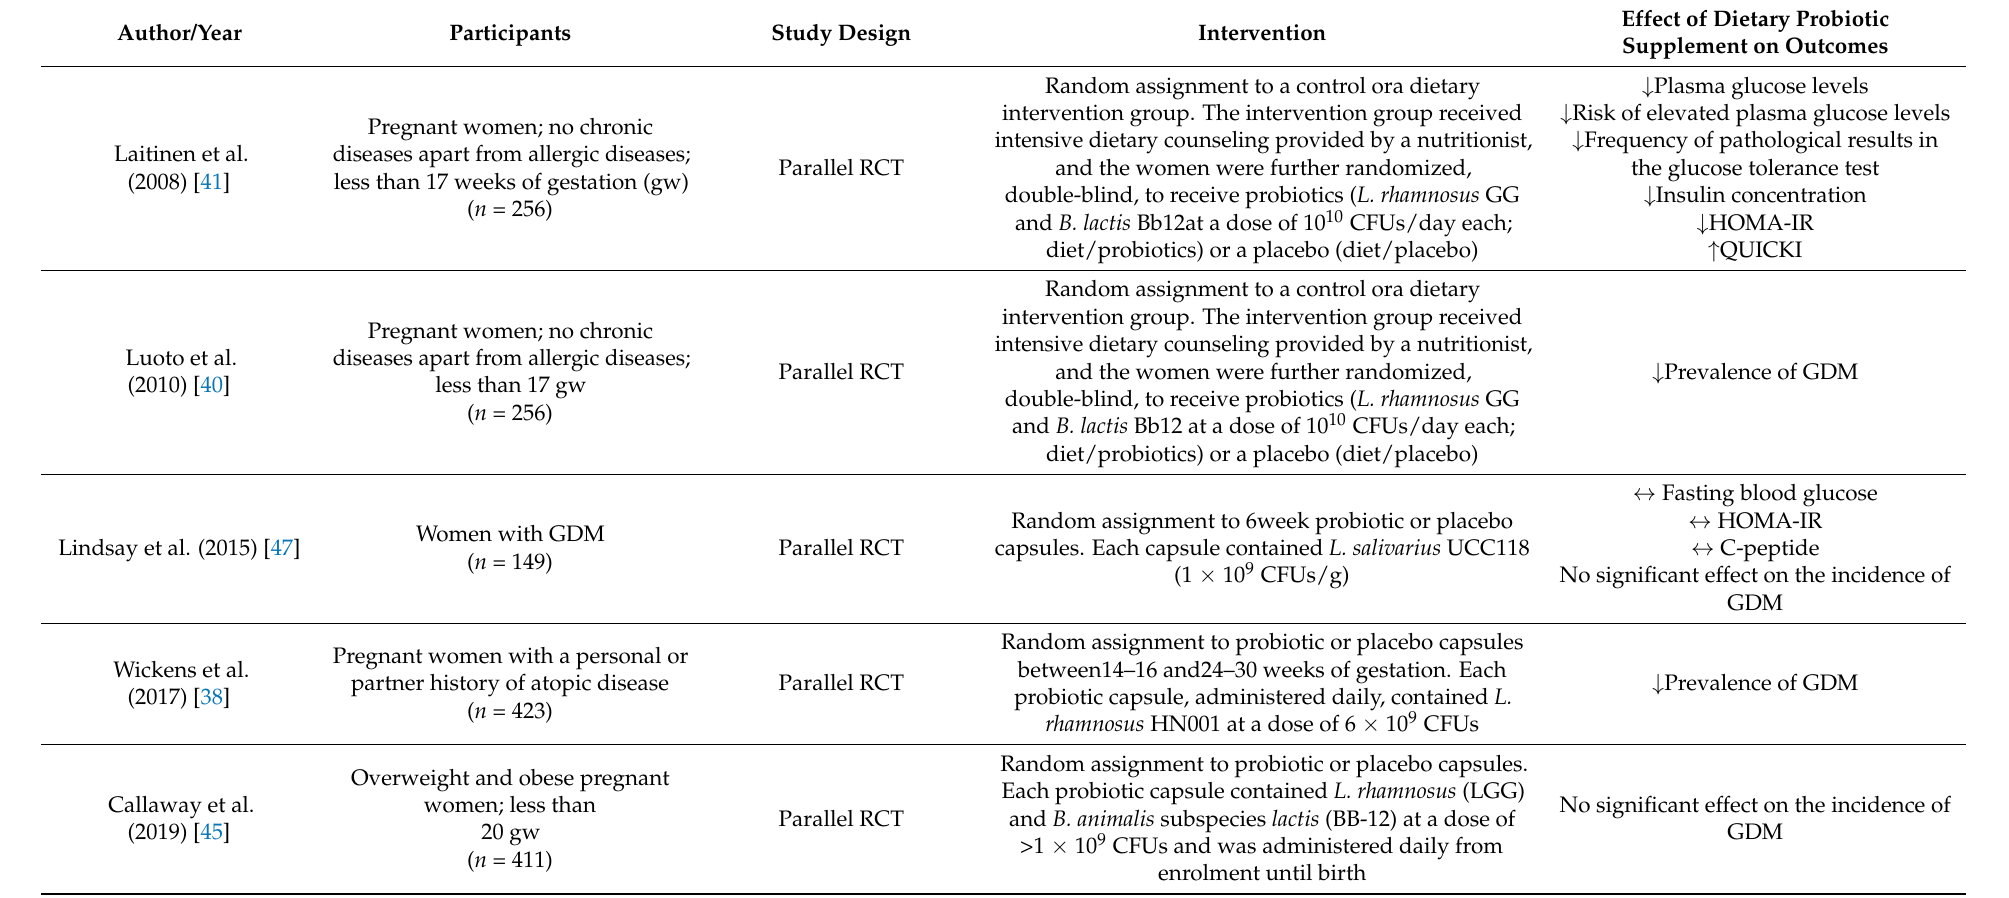
Table 2. Characteristics of randomized controlled trials included in Section 3.1.